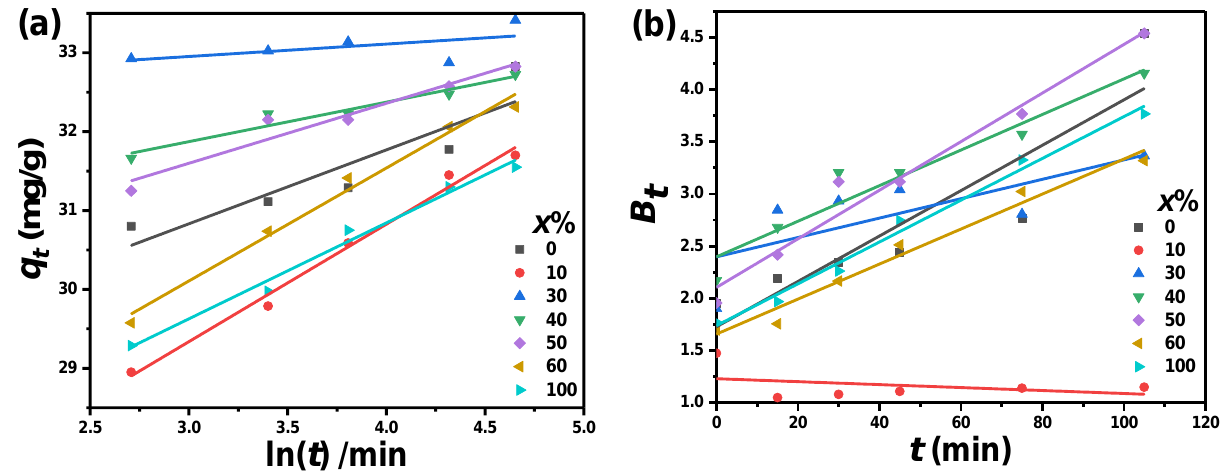
Figure 9. ( a ) the relation between the quantities adsorbed capacity ( q t ) versus ln( t ), and ( b ) B t versus the irradiation time ( t ) for the adsorption of MB using PbO- x %Al 2 O 3 composites as a catalyst.